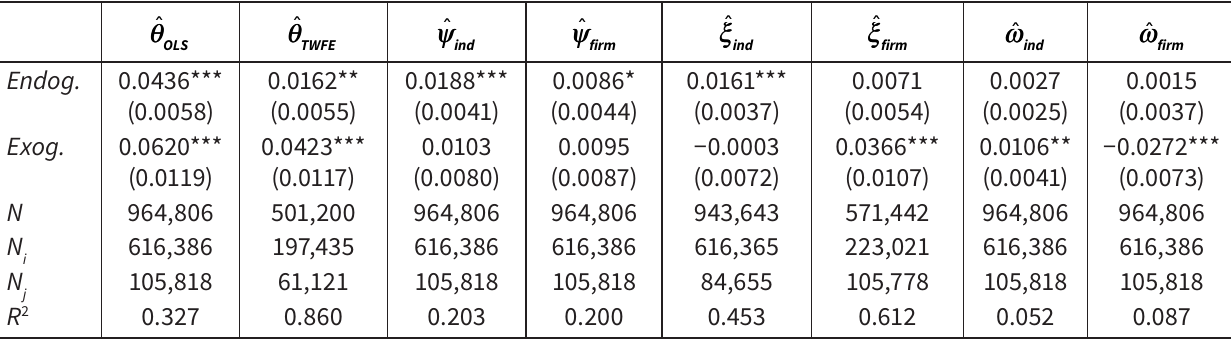
Endogenous and exogenous job